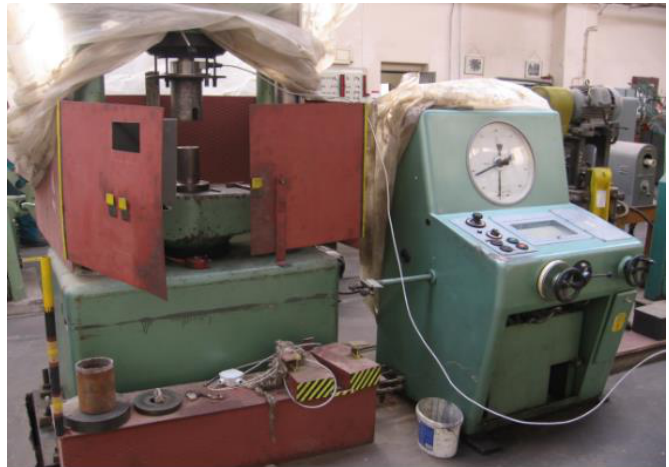
Figure 1. The hydraulic press used in the experiment.